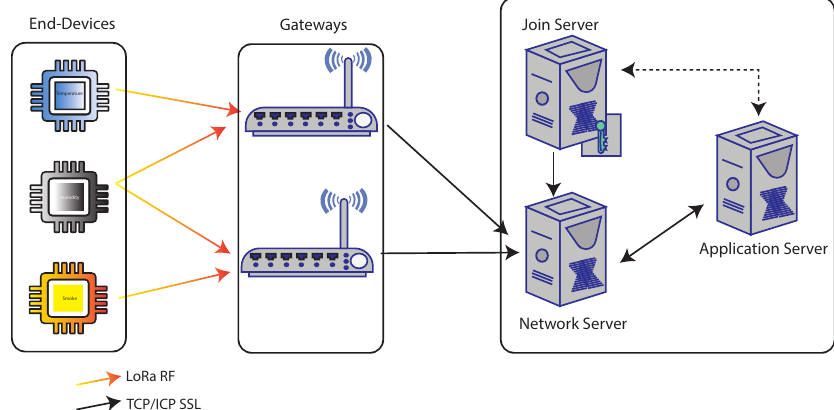
Figure 1. Network architecture of